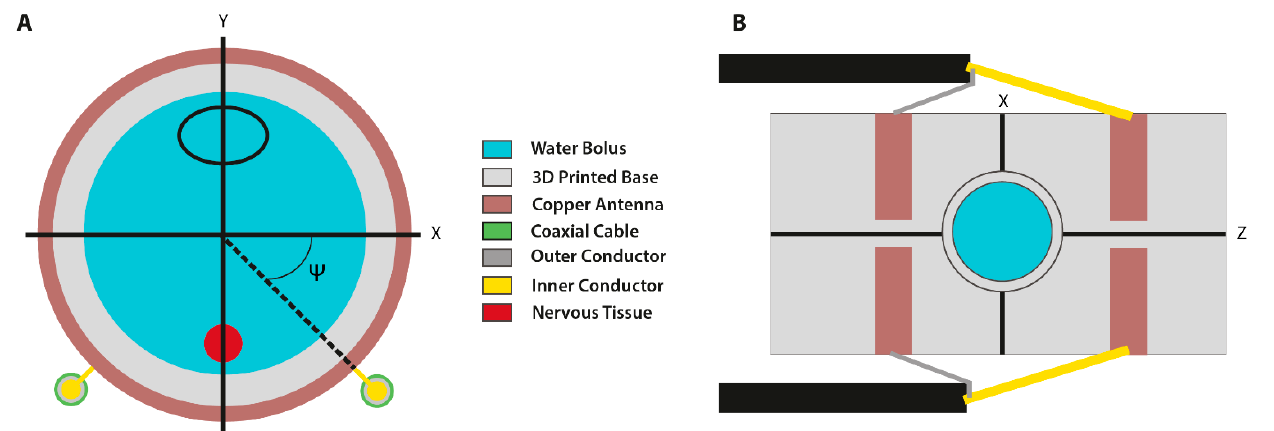
Figure 9. Schematic representation of the cylindrical RF device in ( A ) the X,Y plane and ( B ) the X,Z plane. ( A ) The generation of an oscillating electromagnetic field occurred through the inner/outer connections of the coaxial cable to the semi-circle antennas. The black oval represents the position of the tumor in the model. The red filled circle indicates the position of the central nervous system. Angle Ψ is the optimal angle to steer the heat focus towards the tumor. ( B ) Upper view of the CRF device. The view port was located in the middle of the device, between the four semi-circle copper antennas.